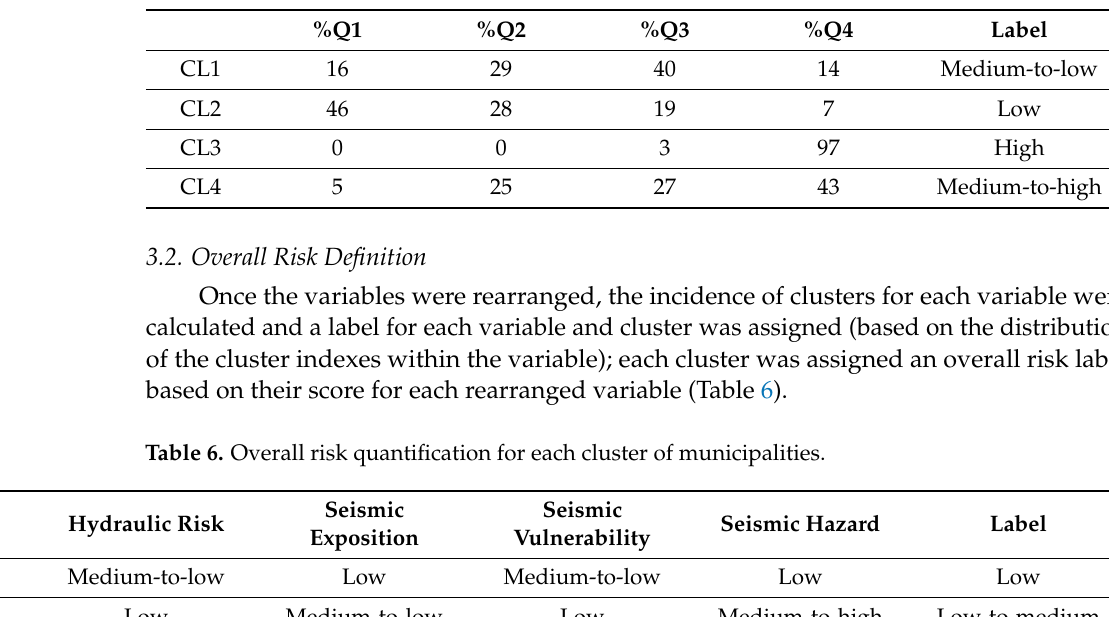
Table 5. Quartile distribution of the a g , max variable in the four clusters.